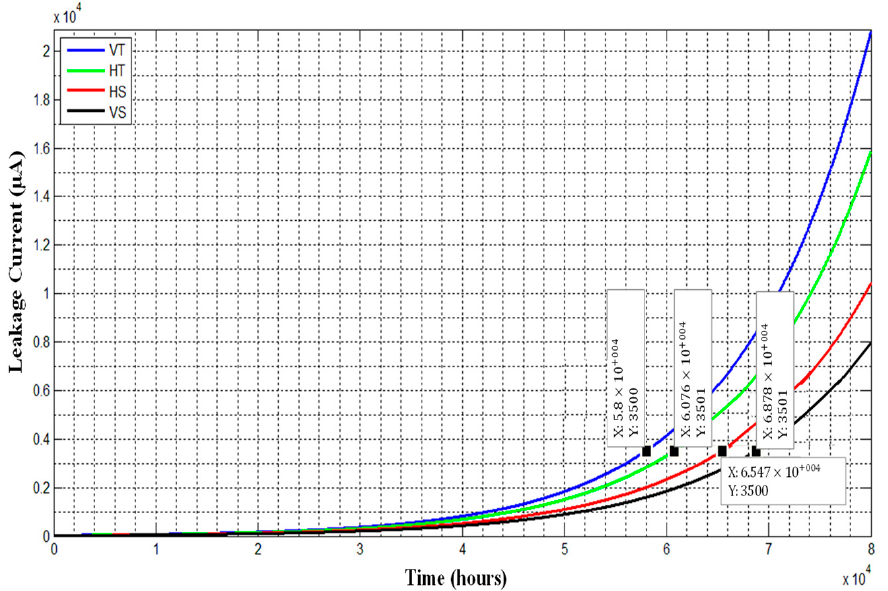
Figure 11. Extrapolation on results of exponential regression.